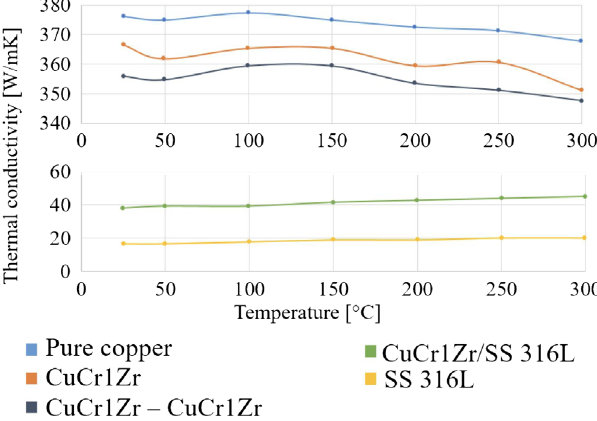
FIG. 11. Thermal conductivity measurements at the materials bulks and